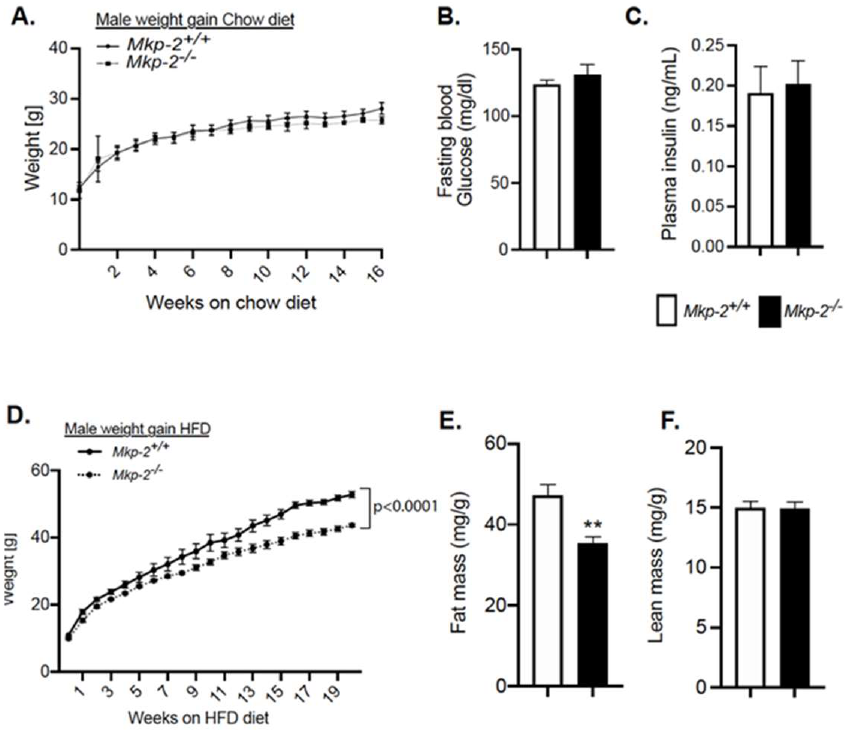
Figure 3. Resistance to Diet-Induced Obesity and Insulin Sensitivity in Male MKP-2-Deficient Mice. ( A ) Weight curves of chow-fed Mkp-2 +/+ and Mkp-2 − / − mice for 16 weeks; ( B ) fasting blood glucose; ( C ) plasma insulin; ( D ) weight curves of HFD-fed Mkp-2 +/+ and Mkp-2 − / − mice for 24 weeks; ( E ) fat mass; and ( F ) lean mass (N = 10 mice/genotype). Results represent the mean ± SEM; ** p < 0.01, as determined by Student’s t -test or in ( A , D ) by analysis of variance (ANOVA) with Bonferroni’s post-test for multiple comparisons. Open bars, Mkp-2 +/+ mice; closed bars, Mkp-2 − / −